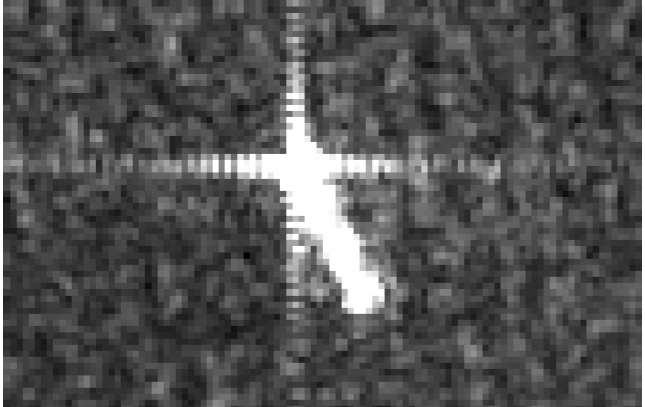
Figure 4. Crop example of a SAR signal containing an individual ship candidate: a clearly visible cross-shaped artifact strongly affects the data quality. Sentinel 1 image, pixel size 10 m, scatterometric range partially saturated for visibility of the